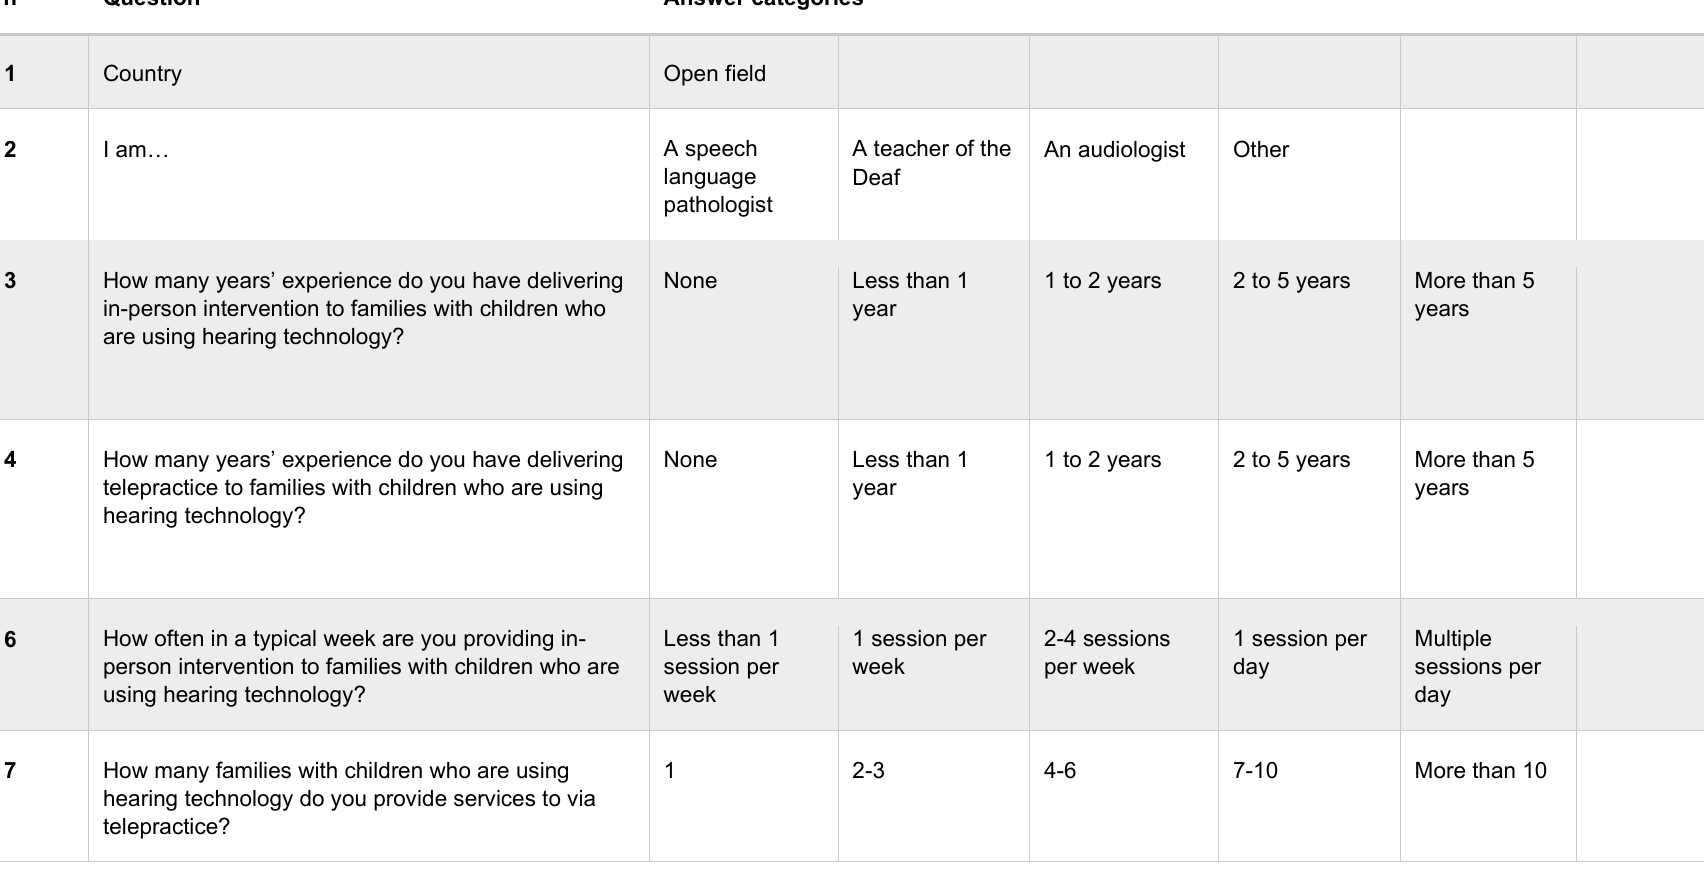
Survey 1 Questions and Answer